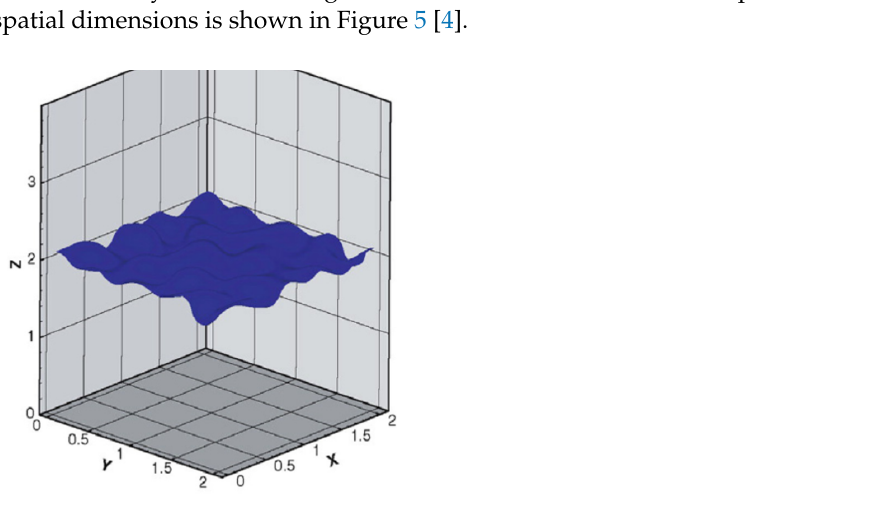
Figure 5. Sinusoidal behavior of individual potential fluctuations in three space dimensions